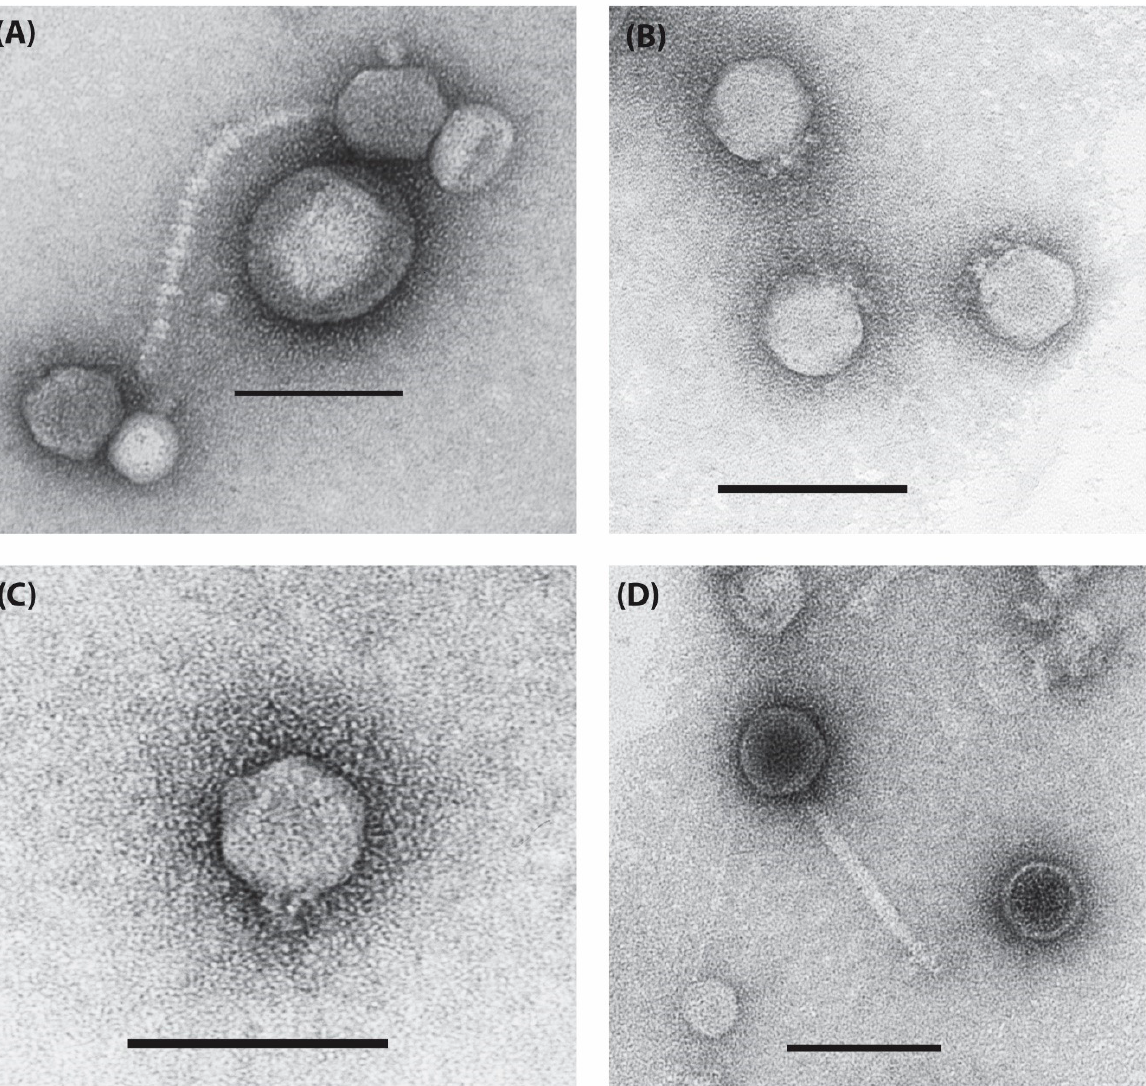
Figure 9. Novel temperate phages of A. baumannii . Transmission electron micrographs of ( A ) RPH5R; ( B ) RPH2R ( C ) TRS2; and ( D ) TRS1, negatively stained with 2% w/v uranyl acetate. Scale bars represent 100 nm.